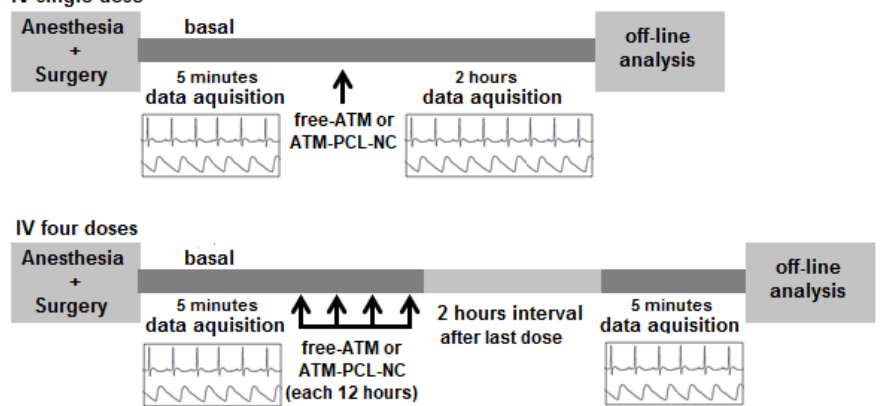
Figure 1. Experimental protocol of vehicle, blank-NC, free-ATM, and ATM-PCL-NC treatment for ECG and AP signal register.